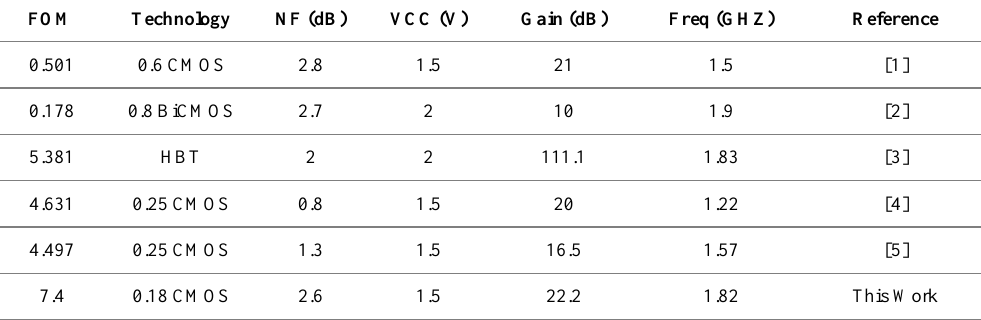
Table 2. Performance comparison between other l-band low noise